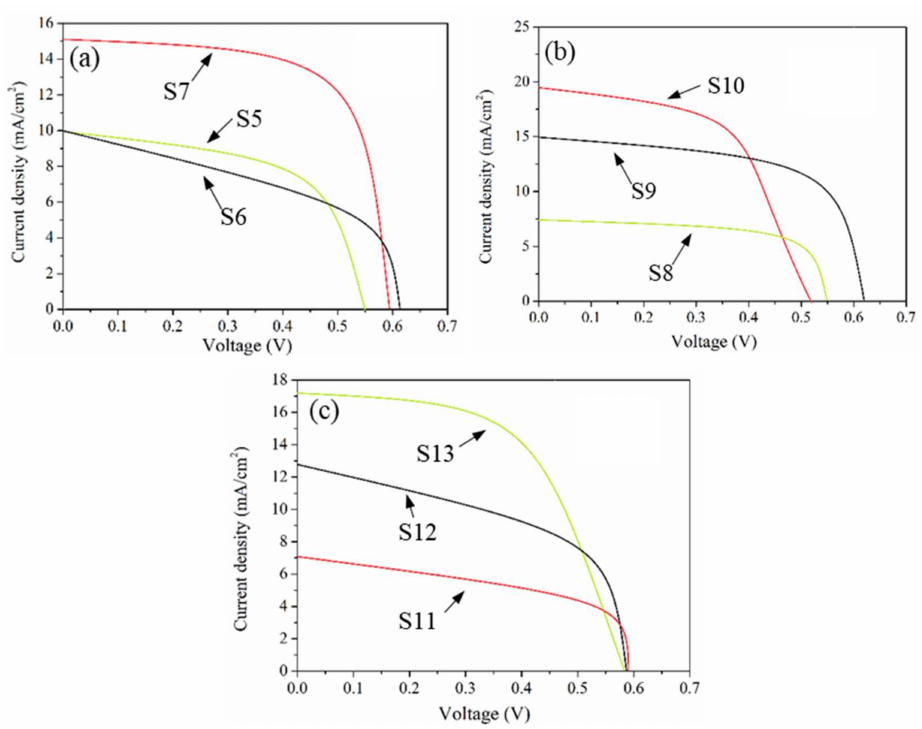
Figure 14. Current–voltage characteristics of the DSSC photovoltaic efficiency of the mixed Acac. and GP with a TiO 2 mesoporous layer, corresponding to Figure 13. ( a ) Fixed Acac 1 mL, various